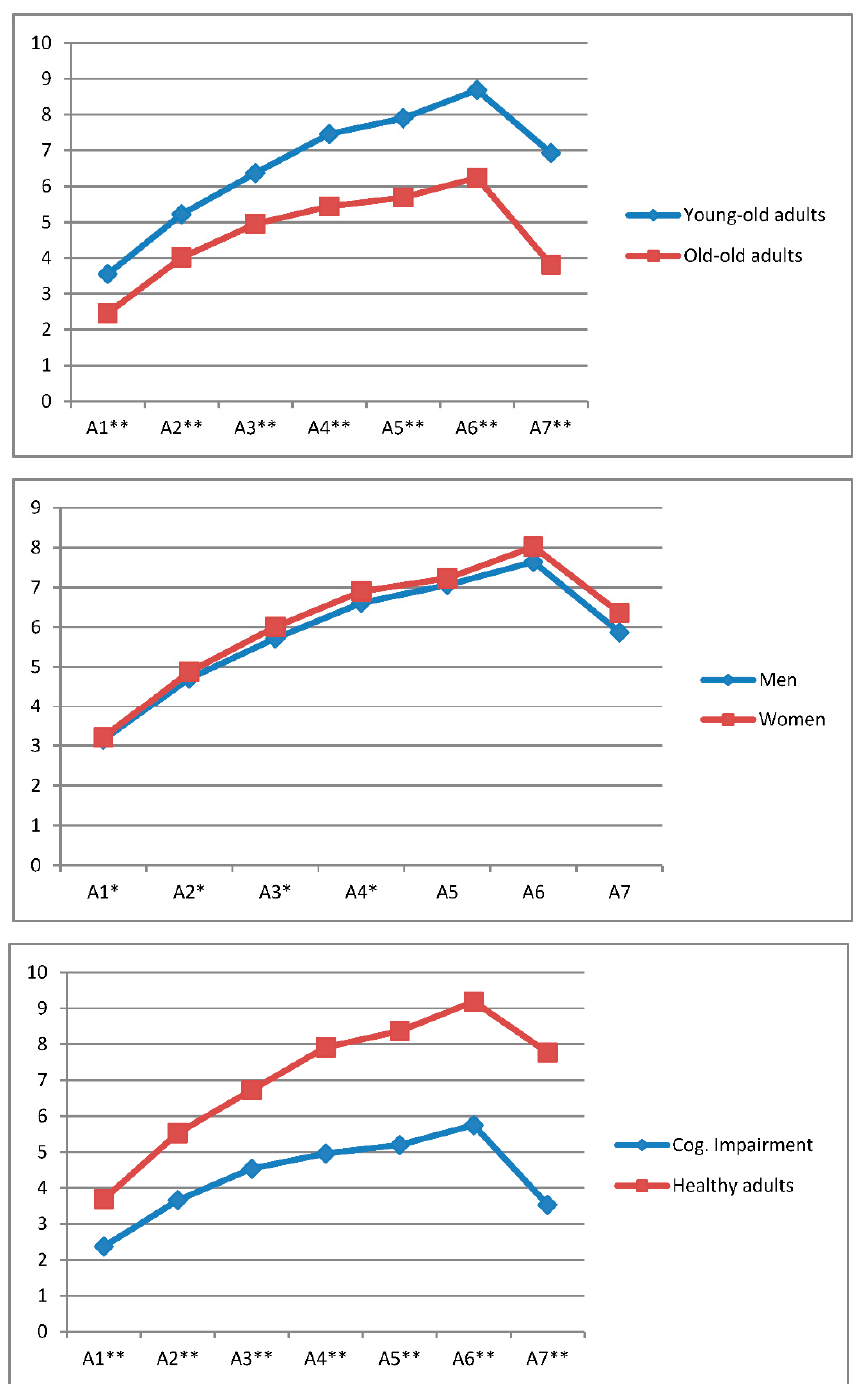
Figure 1. Participants’ learning curves and delayed recall (A7) as a function of age range, gender, and cognitive status. * The difference is significant at 0.05 ( p < 0.05). ** The difference is significant at 0.01 ( p < 0.01).